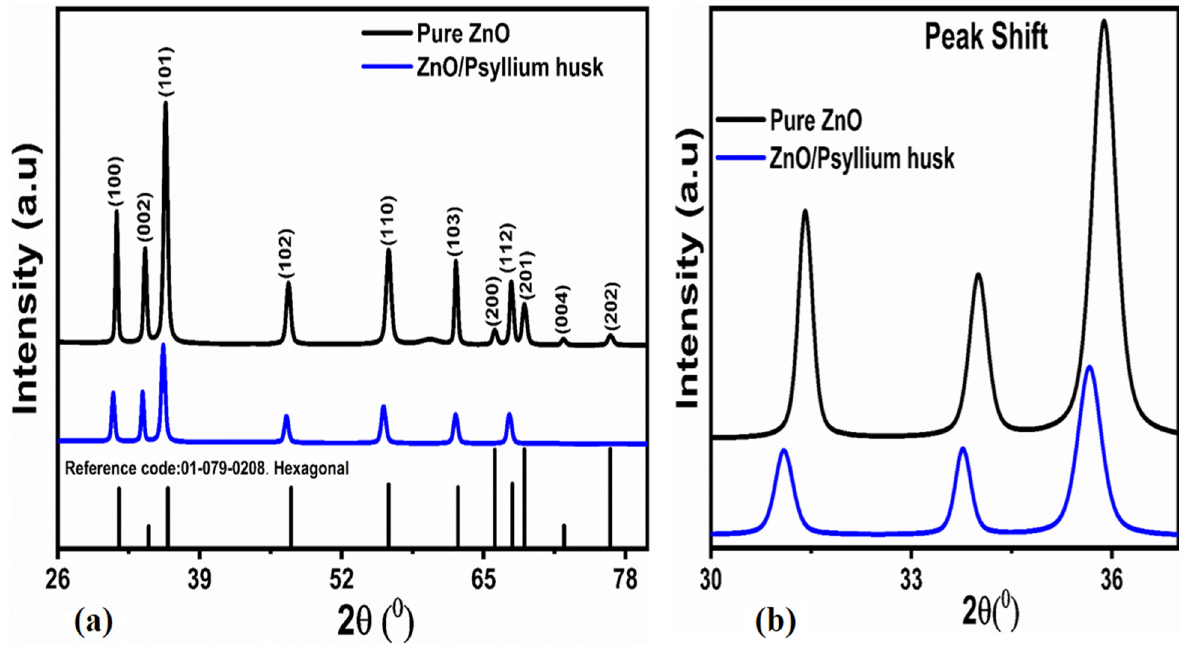
Figure 1. ( a ) XRD diffraction patterns of pure zinc oxide and psyllium-husk-assisted ZnO. ( b ) XRD pattern showing peak shift. Table 1. The relative shift in two theta for psyllium husk assisted ZnO.